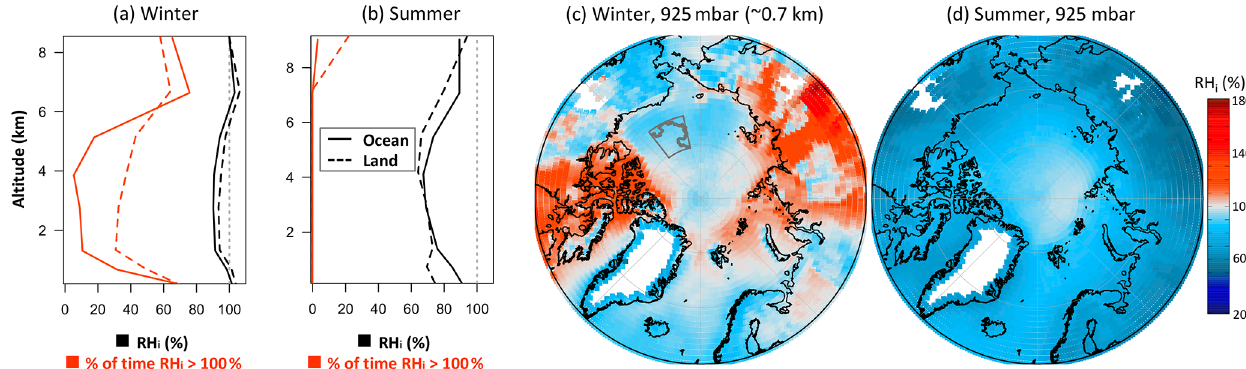
Figure 2. Diamond dust is unlikely to occur during the summer and is more likely to occur during winter, especially over the Canadian Archipelago and over Siberia, based on seasonally averaged RH i distributions for the winter (DJF) and summer (JJA) between 2008–2016. On the left are the vertical average RH i profiles over the Arctic Ocean (solid lines, including areas covered by sea ice) and land regions (dashed lines) for (a) winter and (b) summer. For reference, also shown are the percentages of these regions in which RH i is > 100% (red lines). On the right are RH i distributions at the 925mbar isobar for (c) winter and (d) summer. Also shown in dark grey in (c) is the SHEBA cruise track and the region surrounding it. Diamond dust is most likely to occur where RH i values are > 100% (red regions).